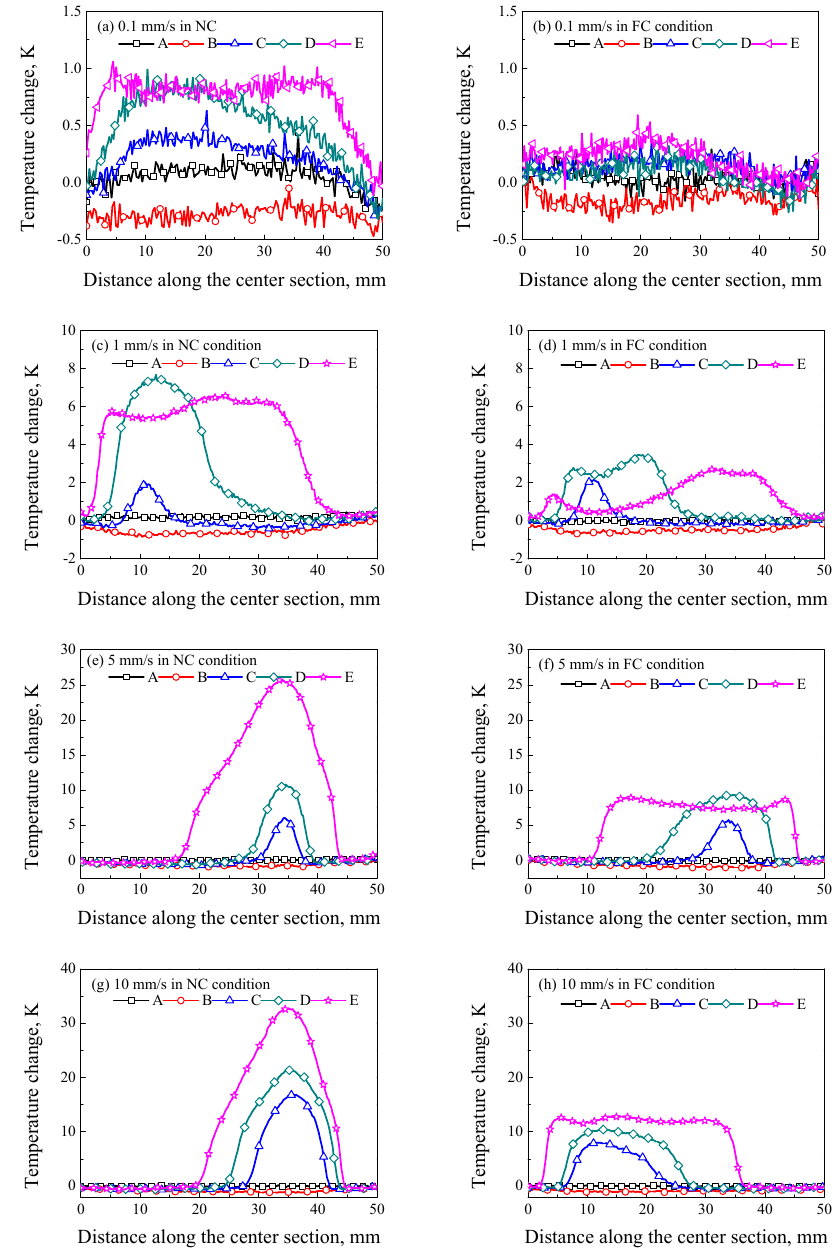
Figure 10. Temperature changes along the center section of specimens at di ff erent loading rates of ( a ) 0.1 mm / s in the NC condition; ( b ) 0.1 mm / s in the FC condition; ( c ) 1 mm / s in the NC condition; ( d ) 1 mm / s in the FC condition; ( e ) 5 mm / s in the NC condition; ( f ) 5 mm / s in the FC condition; ( g ) 10 mm / s in the NC condition and ( h ) 10 mm / s in FC